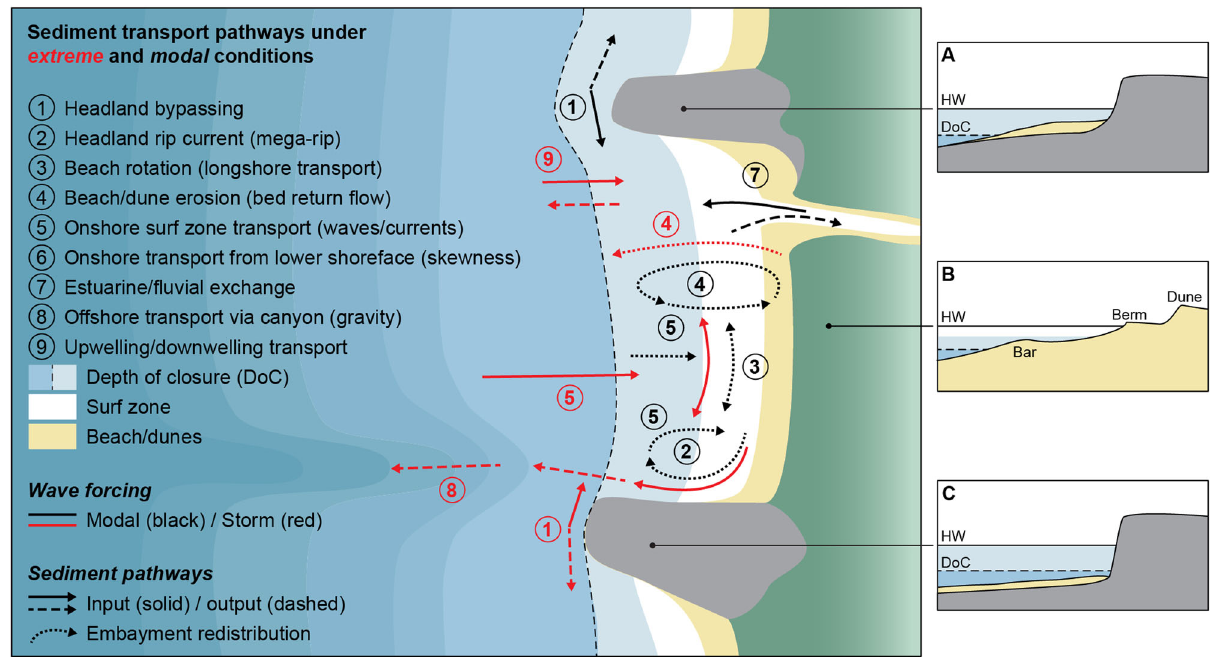
Fig. 1 Key sediment transport pathways under modal and extreme wave conditions on an embayed sandy beach. Red arrows denote sediment transport pathways during extreme storm conditions and black arrows during less-energetic modal conditions. Example cross-sections at three locations in the beach compartment are: A a rocky headland with sandy bed above the depth of closure (DoC); B a completely sandy beach system; and C a rocky headland with the sandy bed below the depth of closure.